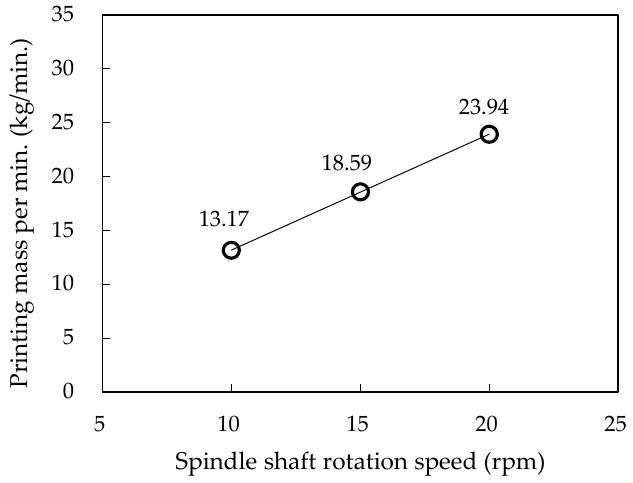
Figure 10. Designed printing test schedule for straight line.